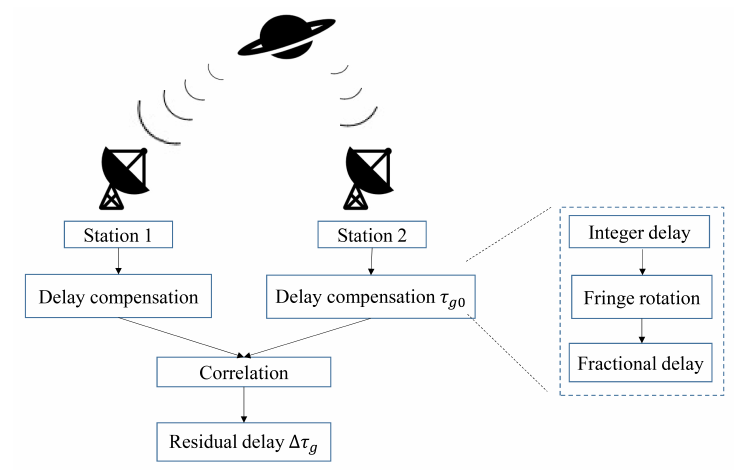
Figure 2. The structure of VLBI